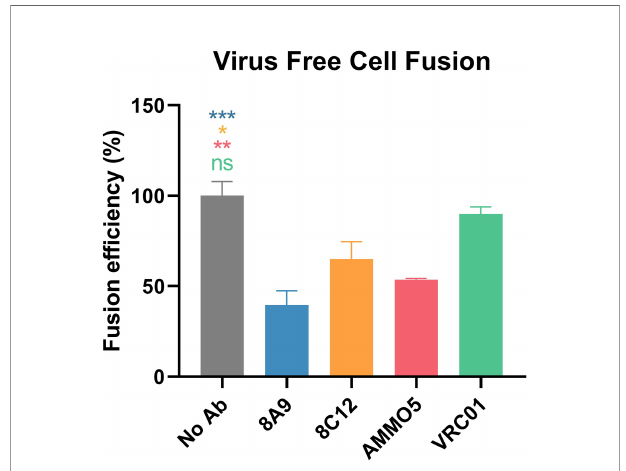
FIGURE 7 | Inhibition of cell – cell fusion by gB NAbs. Evaluation of gB NAbs using a virus-free cell fusion assay. Relative fusion ef fi ciency was calculated in percentage terms. All data are presented as mean ± SEM. * p < 0.05; ** p < 0.01; *** p < 0.001; ns, not signi fi